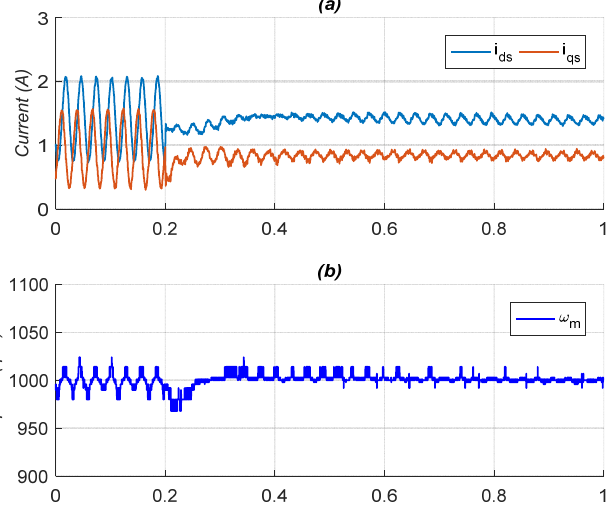
Figure 9. Postfault waveform of ( a ) the d-q current and ( b ) mechanical speed from the three-phase IM drive before and after feedforward injection at 0.2 s.